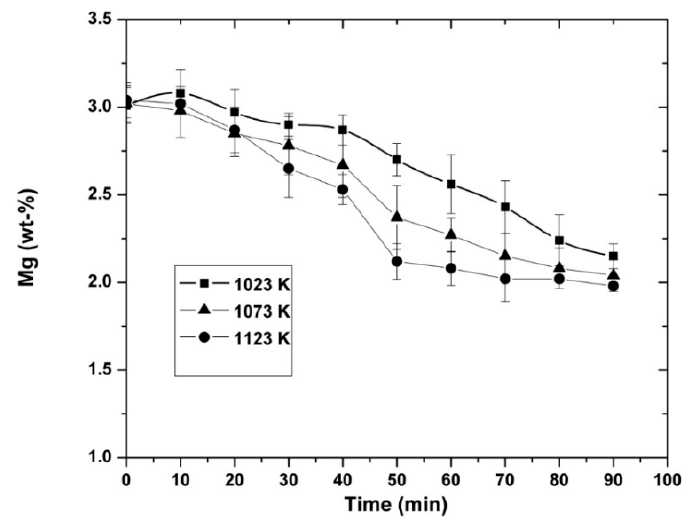
Figure 5. Decrease of the magnesium concentration in molten aluminum as a function of injection time at the indicated temperatures at the constant agitation speed of 300 rpm.